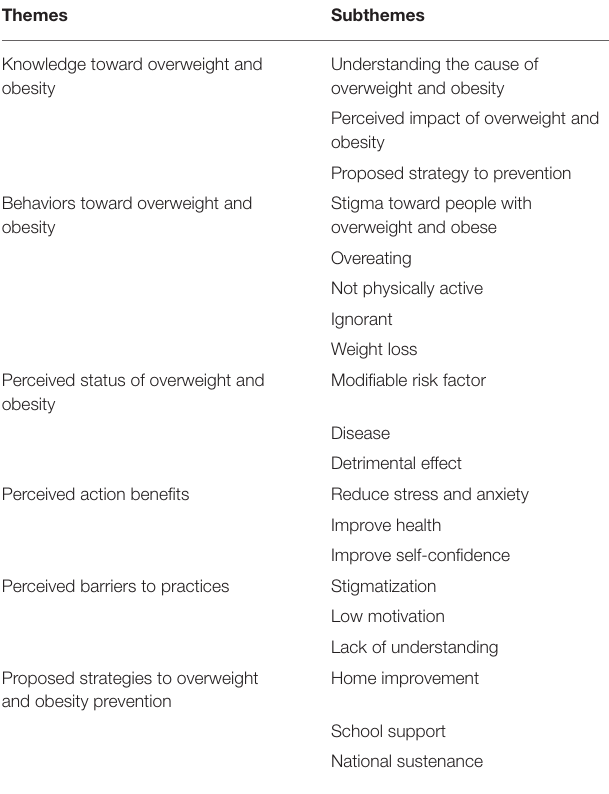
TABLE 2 | Themes extracted from